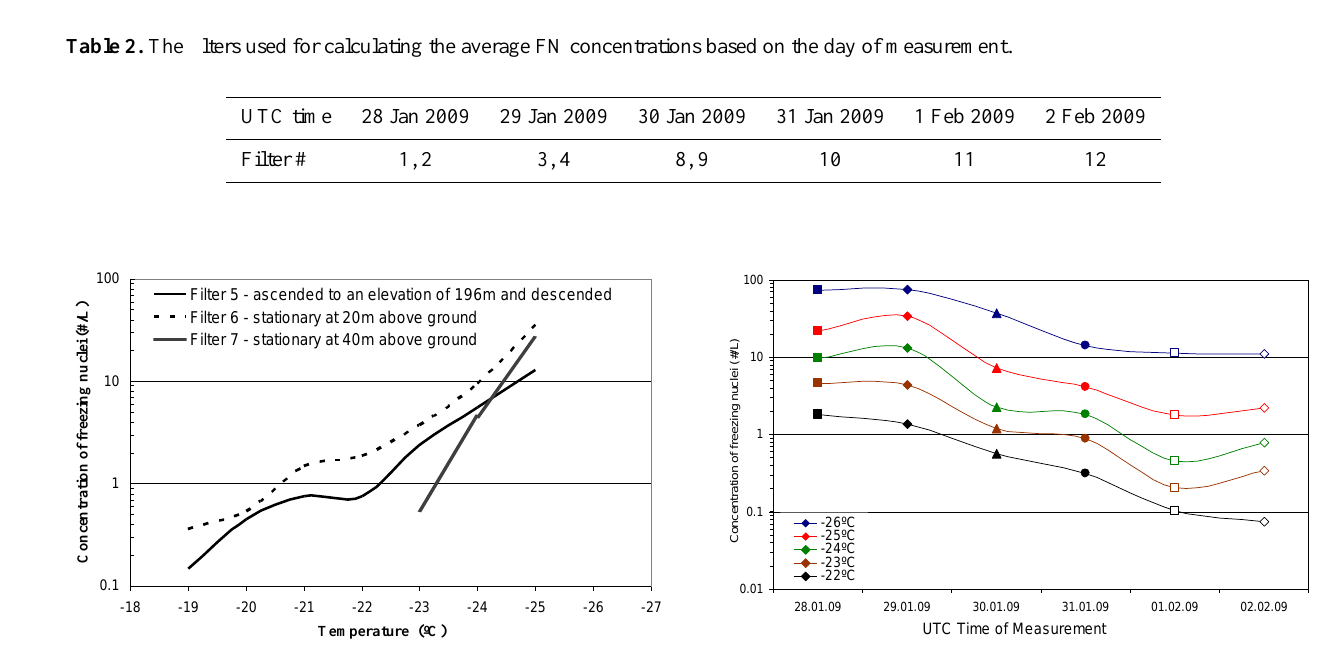
Fig. 5: Concentration of freezing nuclei from samples collected on the balloon. Fig. 5. Concentration of freezing nuclei from samples collected on the balloon.